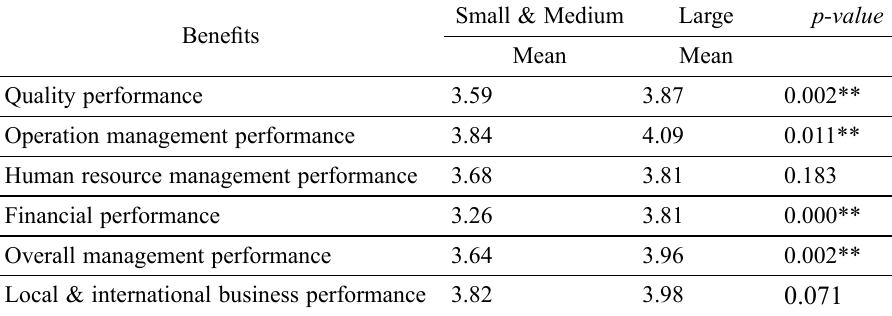
Table 6. Effects of ISO 9001certification classified by size of